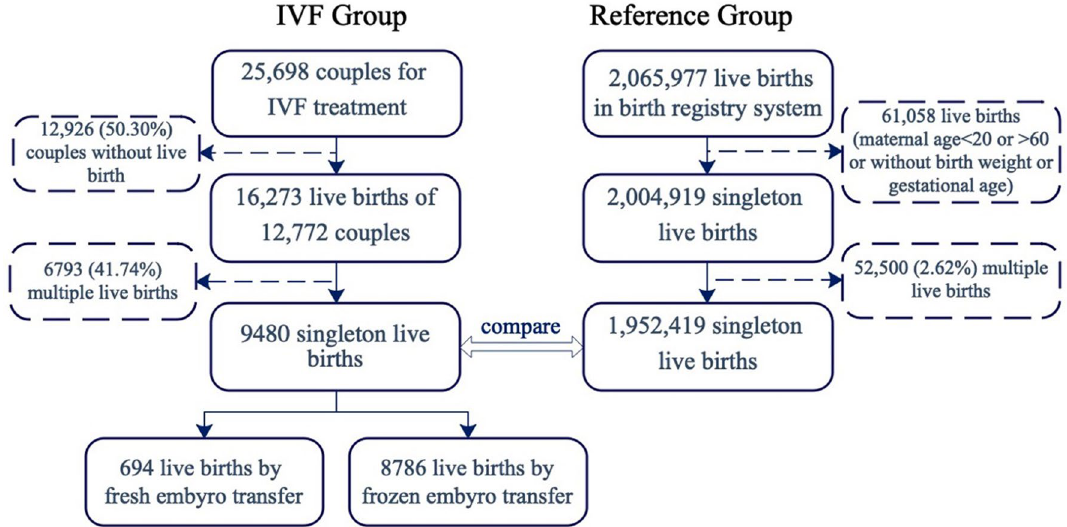
Figure 1. Flow chart of participants included in the